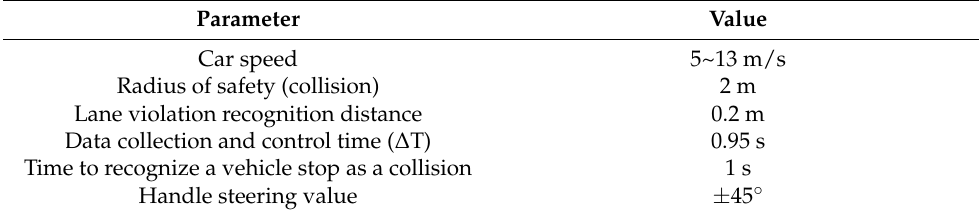
Table 2. Environments for autonomous driving model learning.